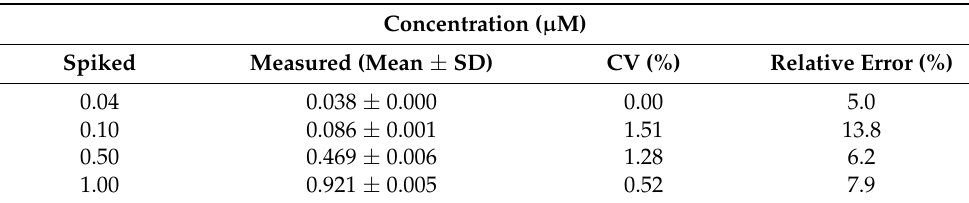
Figure 4. Chromatograms of drug-free CSF ( A ); lower limit of quantitation (0.04 µ M) topotecan and the IS ( B ). Table 1. Sensitivity, accuracy, and precision of the HPLC method in the measurement of topotecan concentration in human cerebrospinal